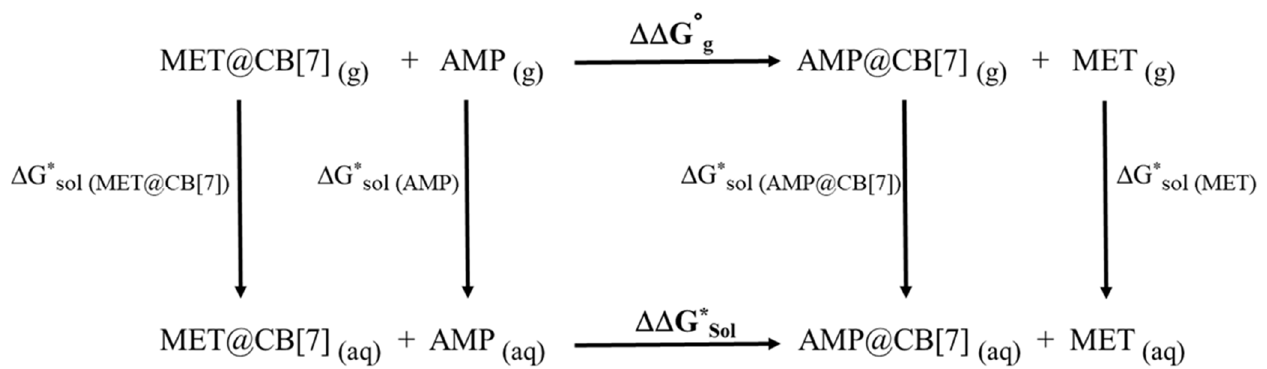
Table 3. Thermodynamic parameters used for the computation of standard free energy change. Species ∆ G 0 gas